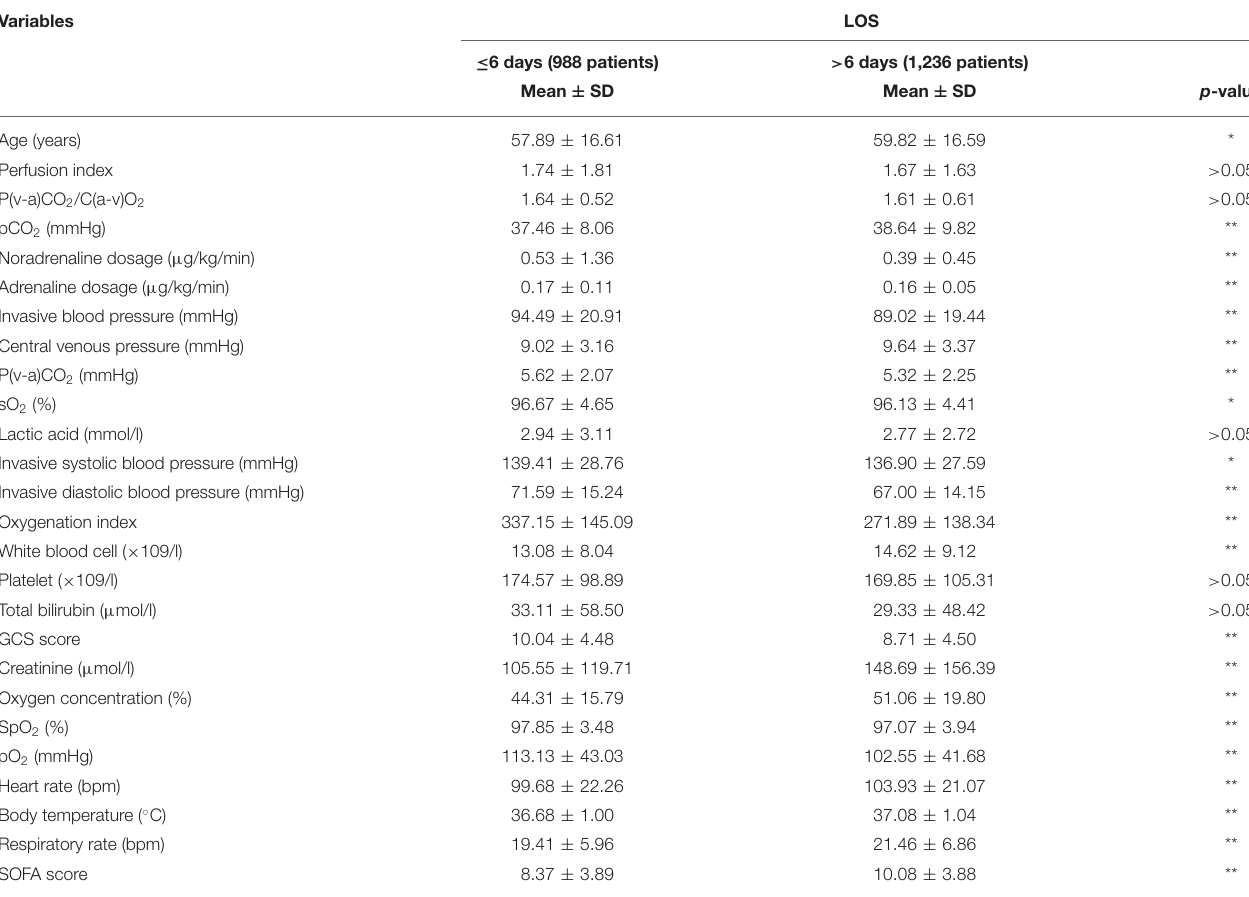
Table 1C | Subgroups of patients’ clinical data for the LOS prediction.